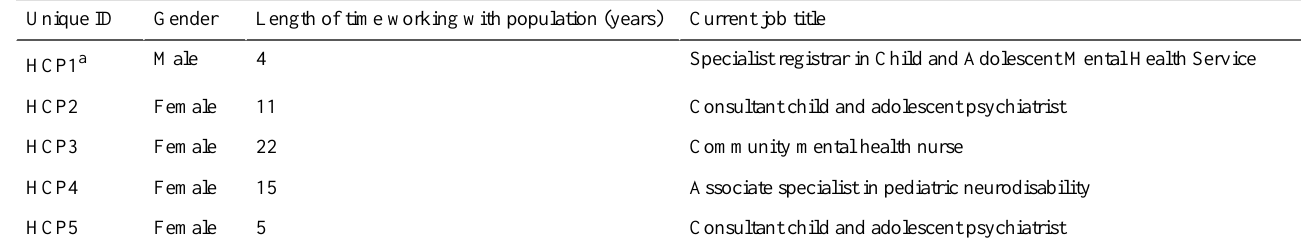
Table 5. Demographic characteristics of clinicians demonstrating a total of more than 57 years of experience working with children and young people with attention-deficit/hyperactivity disorder